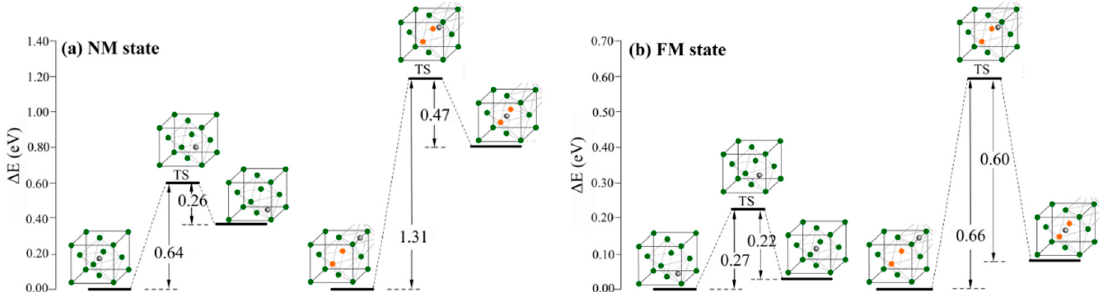
Figure 3. The calculated energetic profiles for interstitial hydrogen diffusion process in Al-free and Al-containing austenites in NM state ( a ) and FM state ( b ).